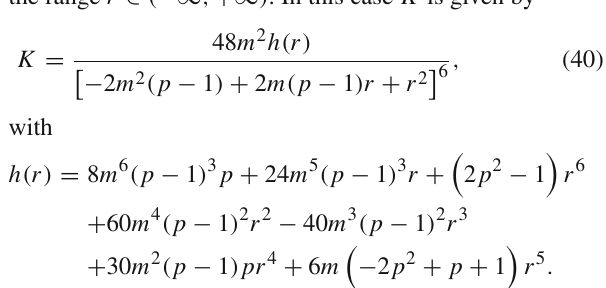
the range r ∈ ( −∞ , +∞ ) . In this case K is given